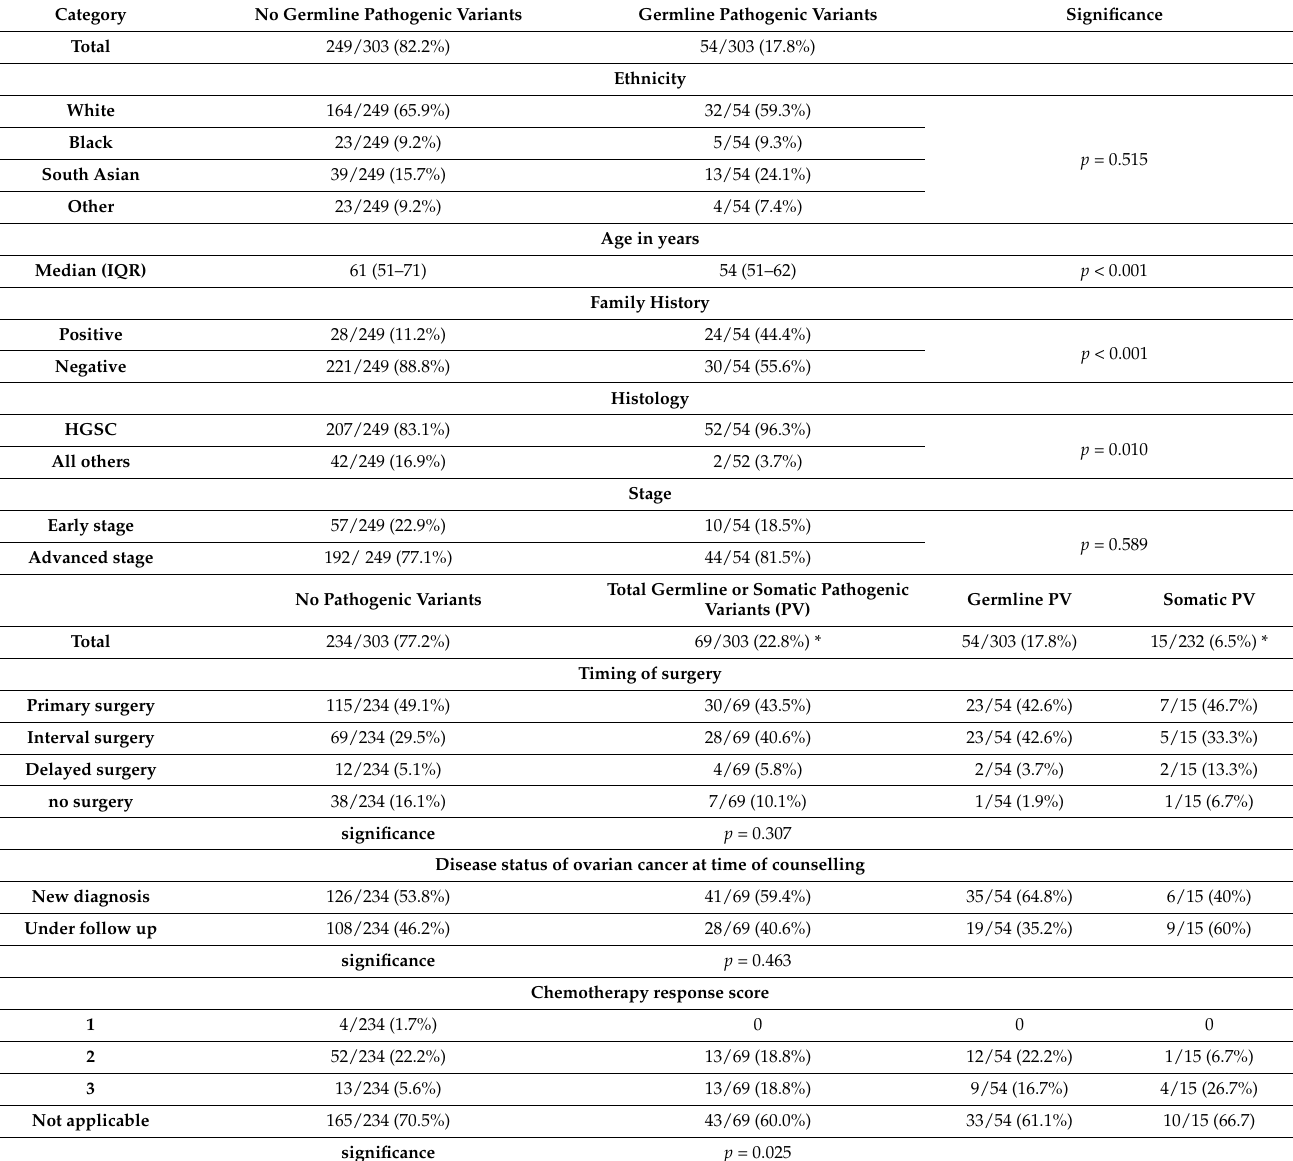
Table 2. Demographic and clinical characteristics NELCN